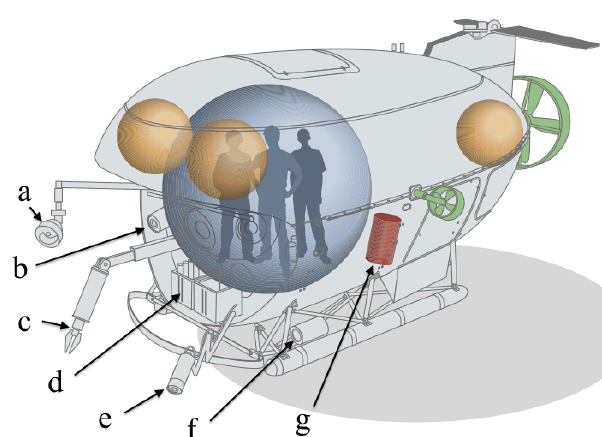
Figure 1: General structure of MIR 1 and 2 submersibles (Adopted from www.elemo.ch ). Examples of onboard instrumentation in- cluded (a) projectors; (b) 3D camera system; (c) articulated arm; (d) sample storage; (e) mobile camera; (f) water sampling device; (g) particle